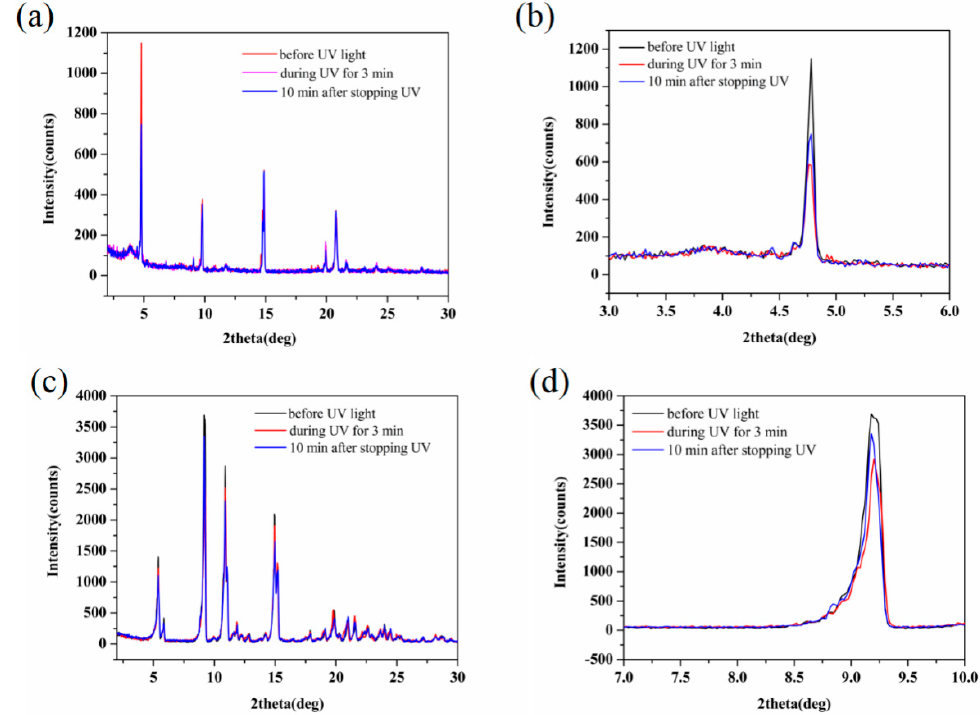
Figure 9. PXRD patterns for ( a , b ) 6cazpy crystal and ( c , d ) complex-I crystal before, during and after UV irradiation. ( b ) The peak at 2 θ = 4.782 ◦ of 6cazpy, ( d ) 2 θ = 9.179 ◦ of complex-I crystals before, during and after UV